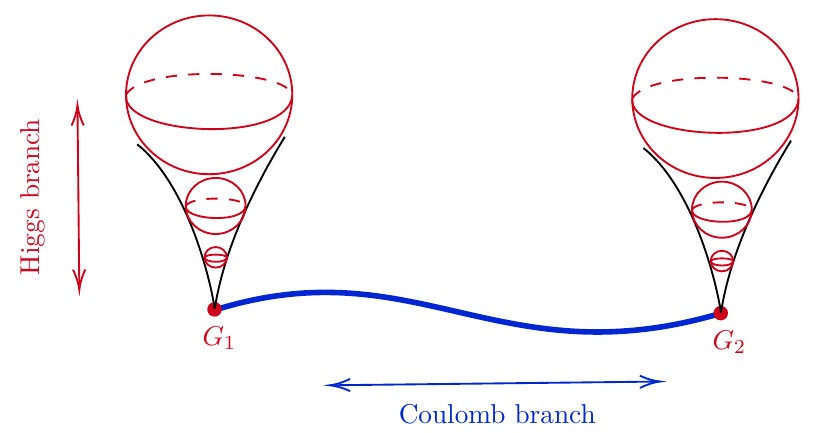
Figure 1 . The above figure shows a path between two instantons in the instanton moduli space. The path connects a G 1 instanton to a G 2 instanton where G 1 and G 2 are independent non-Abelian components of the spacetime gauge group G . We first shrink the G 1 instanton down to zero-size, which corresponds to moving along its Higgs branch to the Coulomb branch. Then we move in the Coulomb branch to deform a G 1 zero-size instanton to a G 2 zero-size instanton. Finally, we can move in the G 2 instanton Higgs branch by increasing the size of the